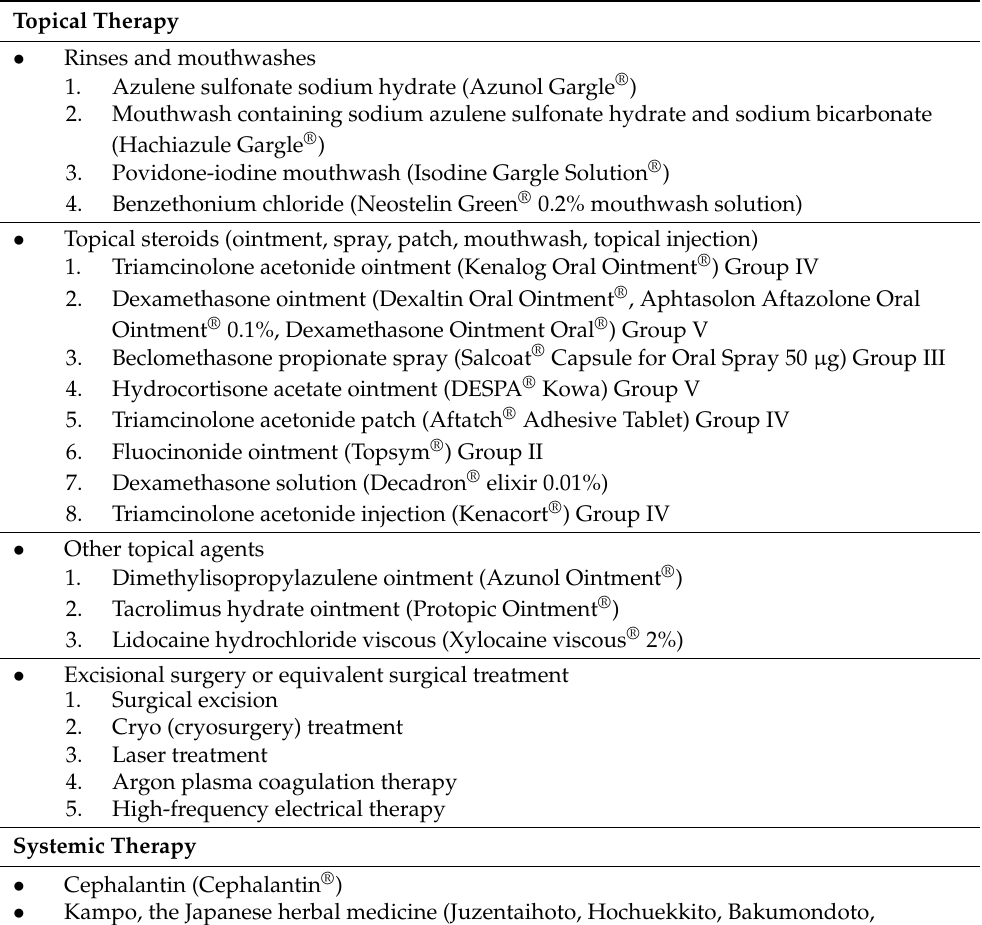
Table 3. New oral lesion interventions that will be prohibited during the crossover study. Topical